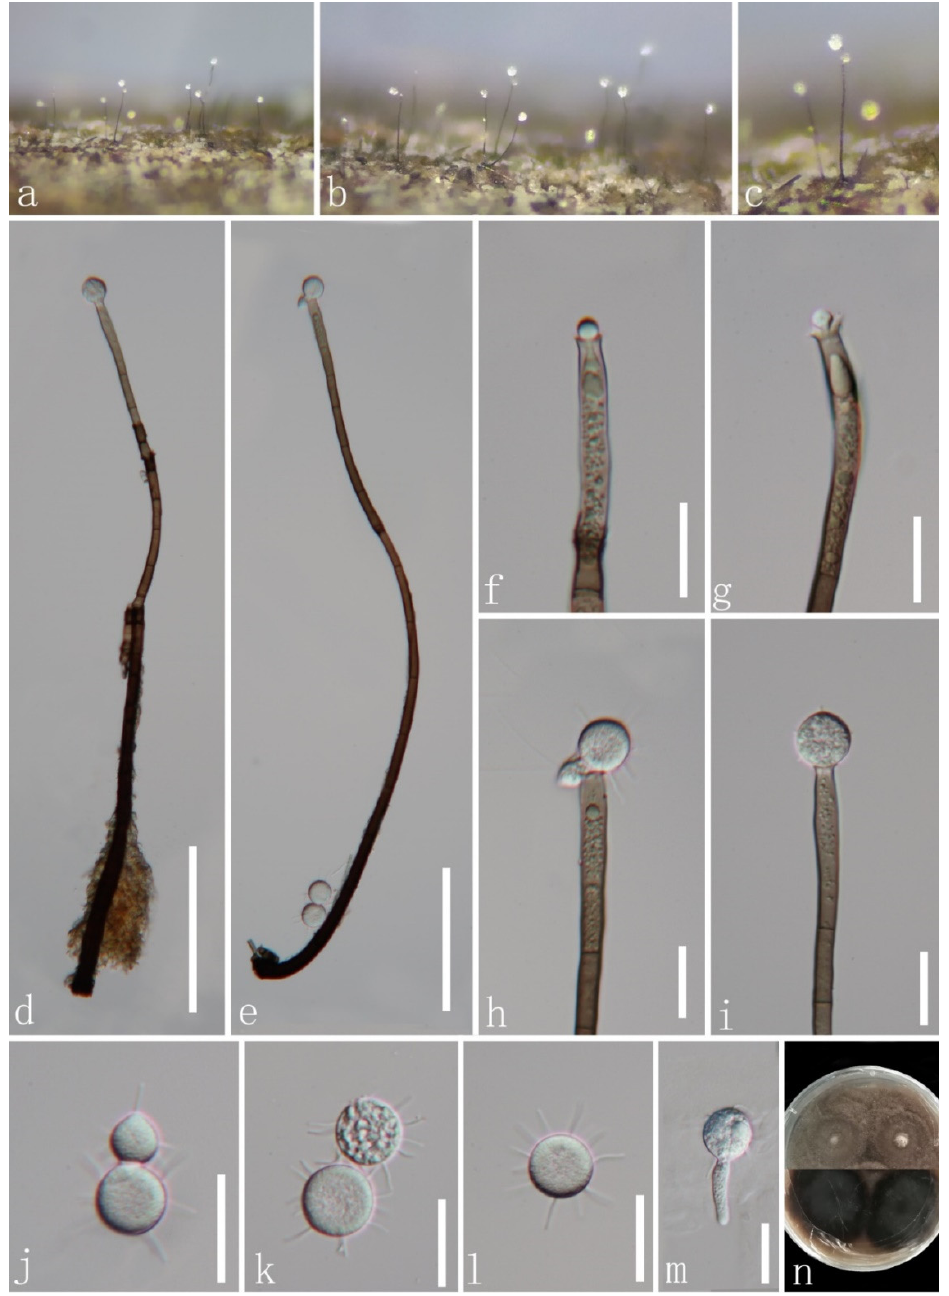
Figure 4. Codinaea dwaya (GZAAS 22-0071). ( a – c ) Colonies on woody substrate; ( d , e ) conidiophores and conidia; ( f – i ) conidiogenous cells; ( j – l ) conidia; ( m ) germinating conidium; ( n ) culture on PDA. Scale bars: ( d , e ) 100 μ m; ( f – m ) 20 μ m.